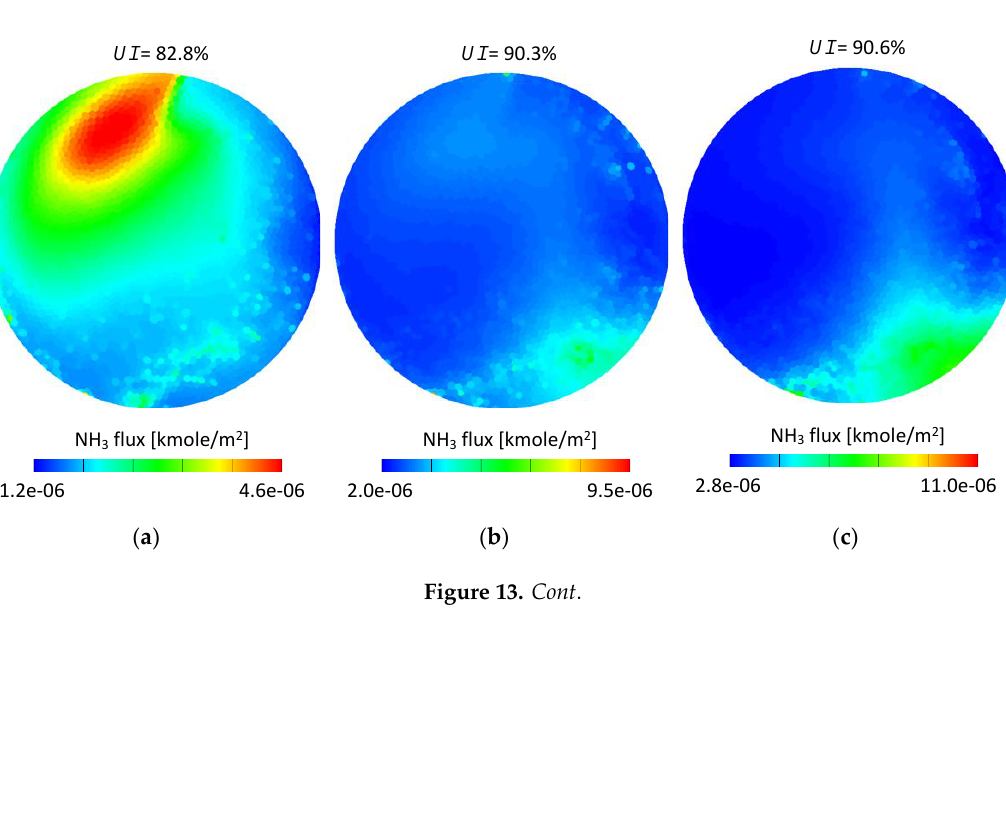
Figure 12. Wall film analysis: ( a ) wall film mass to wall film area ratio at the end of 4th injection cycle; ( b ) relative total wall film mass introduced (normalized by the total mass injected).